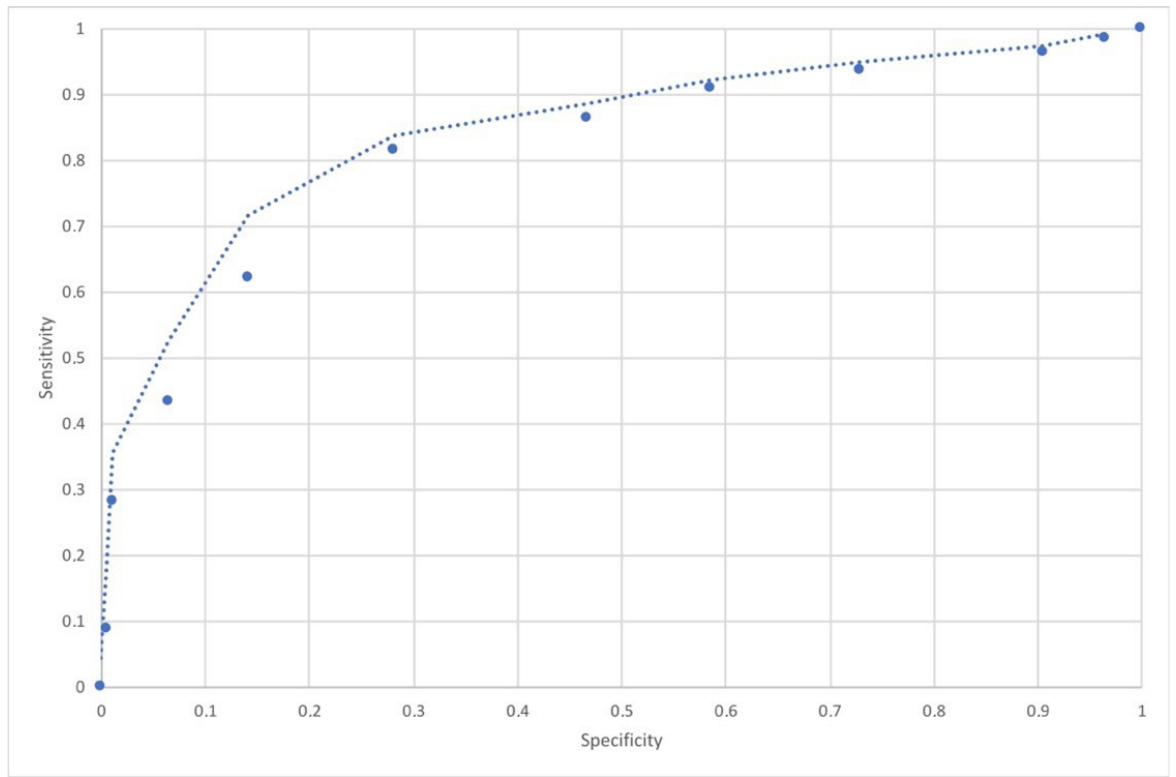
Figure 3 . The figure shows the ROC curve